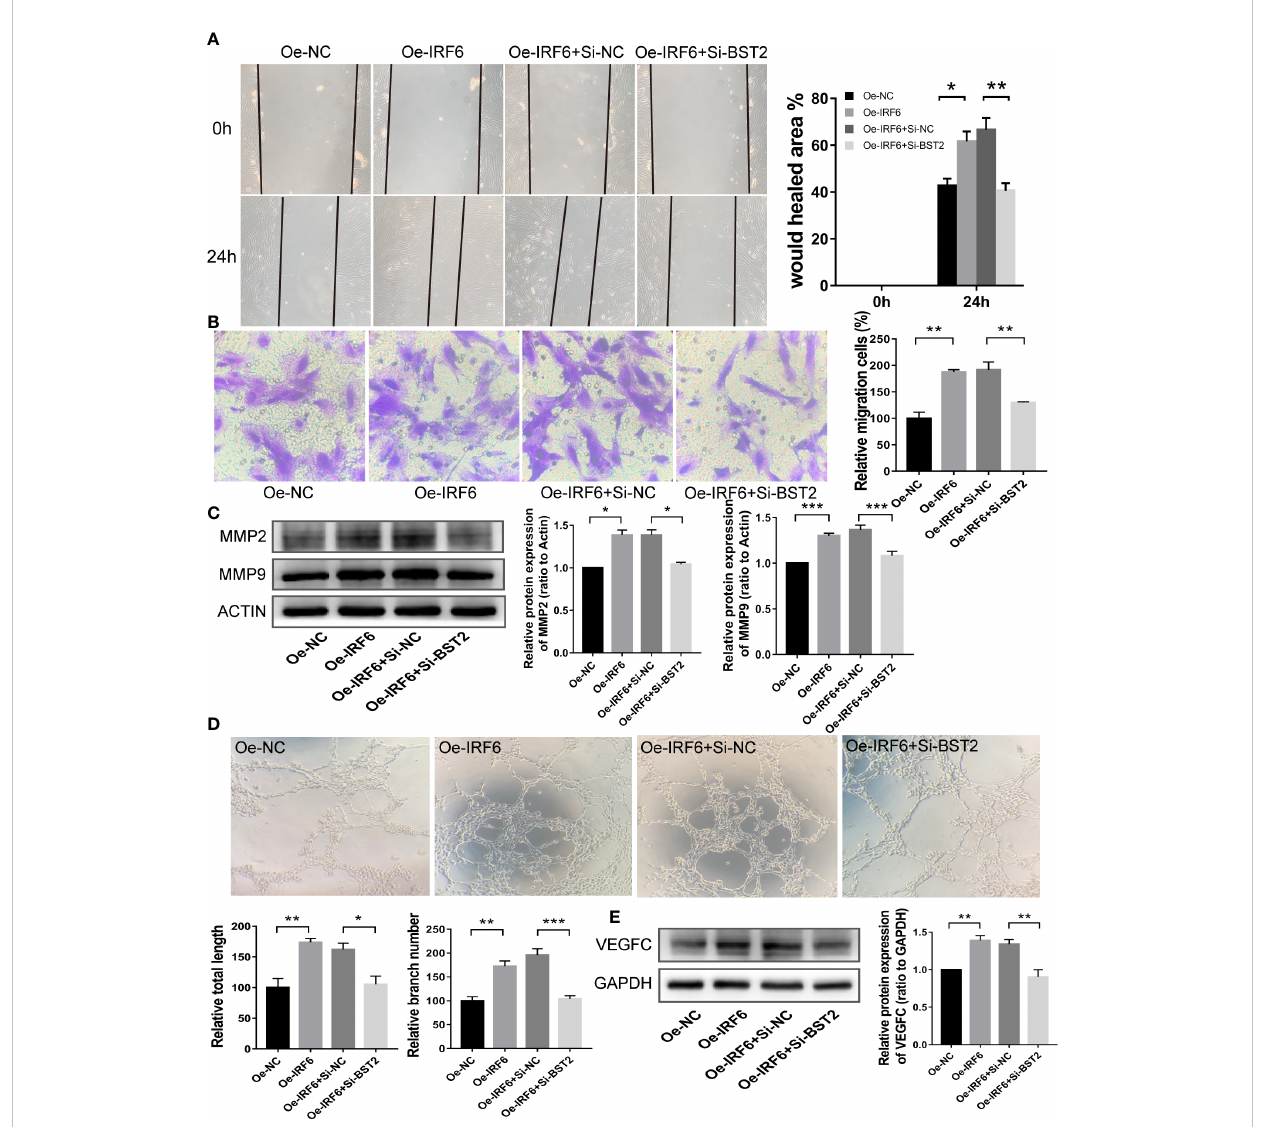
FIGURE 11 BST2 partially rescued the effects of IRF6 on the migration and lymphangiogenesis in EESCs. (A, B) , Wound healing assay (A) and Transwell assay (B) detected the cell migration ability after transfection with Oe-IRF6 and/or Si-BST2 for 48h. (C) , The western blot analysis examined the migration- related proteins after transfection with Oe-IRF6 and/or Si-BST2 for 48h. (D) , The tube formation assay checked the tube formation ability with the CM of EESCs transfected with Oe-IRF6 and/or Si-BST2 on HLECs. (E) , The western blot analysis measured the VEGFC after transfection with Oe-IRF6 and/or Si-BST2. *p < 0.05; **p < 0.01; ***p <